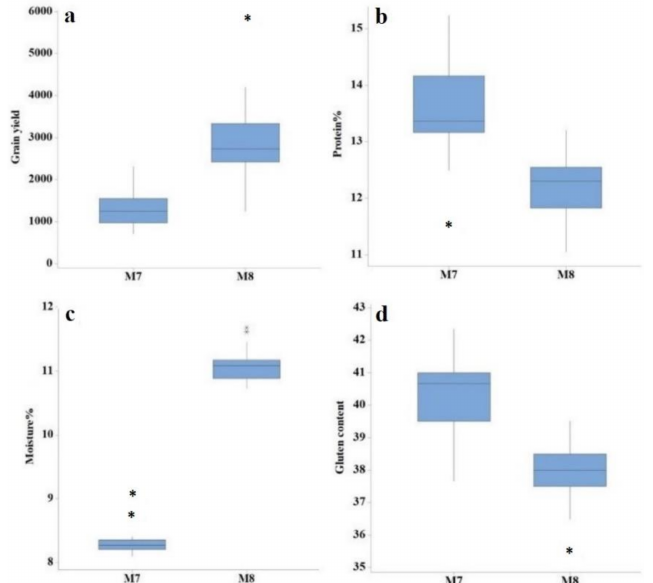
Figure 4. Box plot showing median, minimum, maximum, and mean values: ( a ) grain yield; ( b ) protein%; ( c ) moisture%; ( d ) gluten content at the NIAB location; * represents outliers. 3.2. Mean Values for Various Yield Components, Grain Yield, and Quality Traits